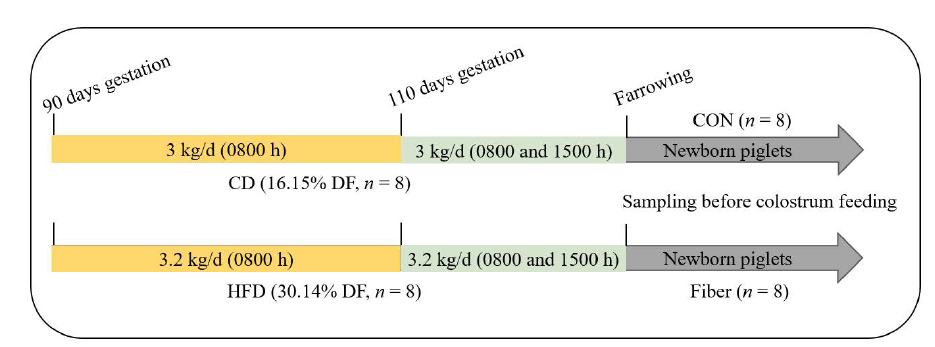
Figure 1. Schematic diagram of experimental design and diet. CD, Control diet; HFD, high dietary fiber diet; CON, Control group; Fiber, Fiber